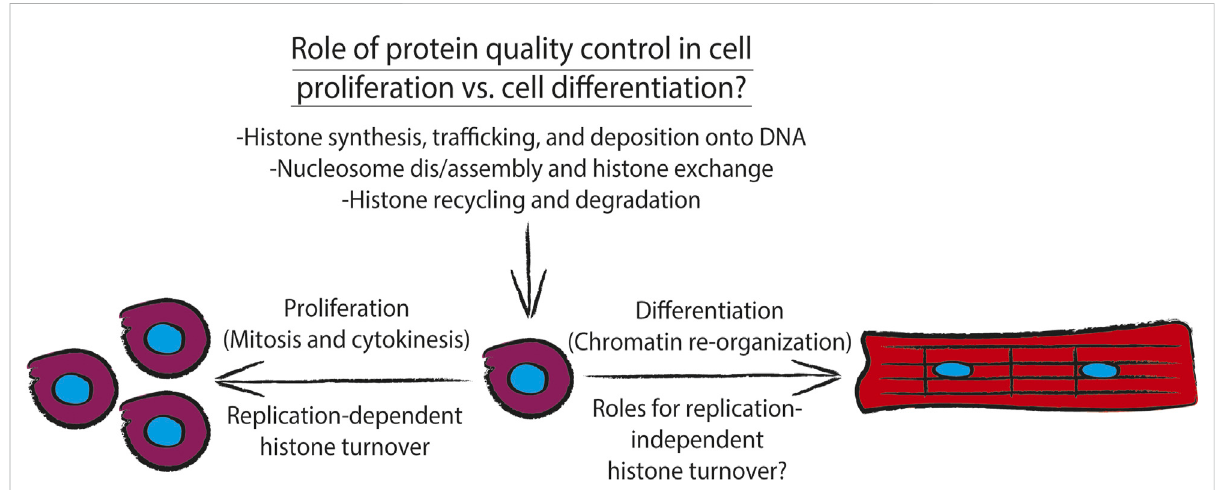
protein quality control. During proliferation, DNA replication-dependent histone turnover, via concerted histone synthesis, traf fi cking, and deposition onto chromatin, along with histone recycling and degradation by the histone chaperone network and ATP-dependent chromatin remodelersdriveproliferation.Additionally,chromatinmustbere-organizedtodrivecelldifferentiation.Todrivecelldifferentiation,thehistone chaperone network and ATP-dependent chromatin remodelers must execute replication-independent histone turnover which also depends on concerted histone synthesis, traf fi cking, and deposition onto chromatin, along with histone recycling and degradation of replication-independent histone